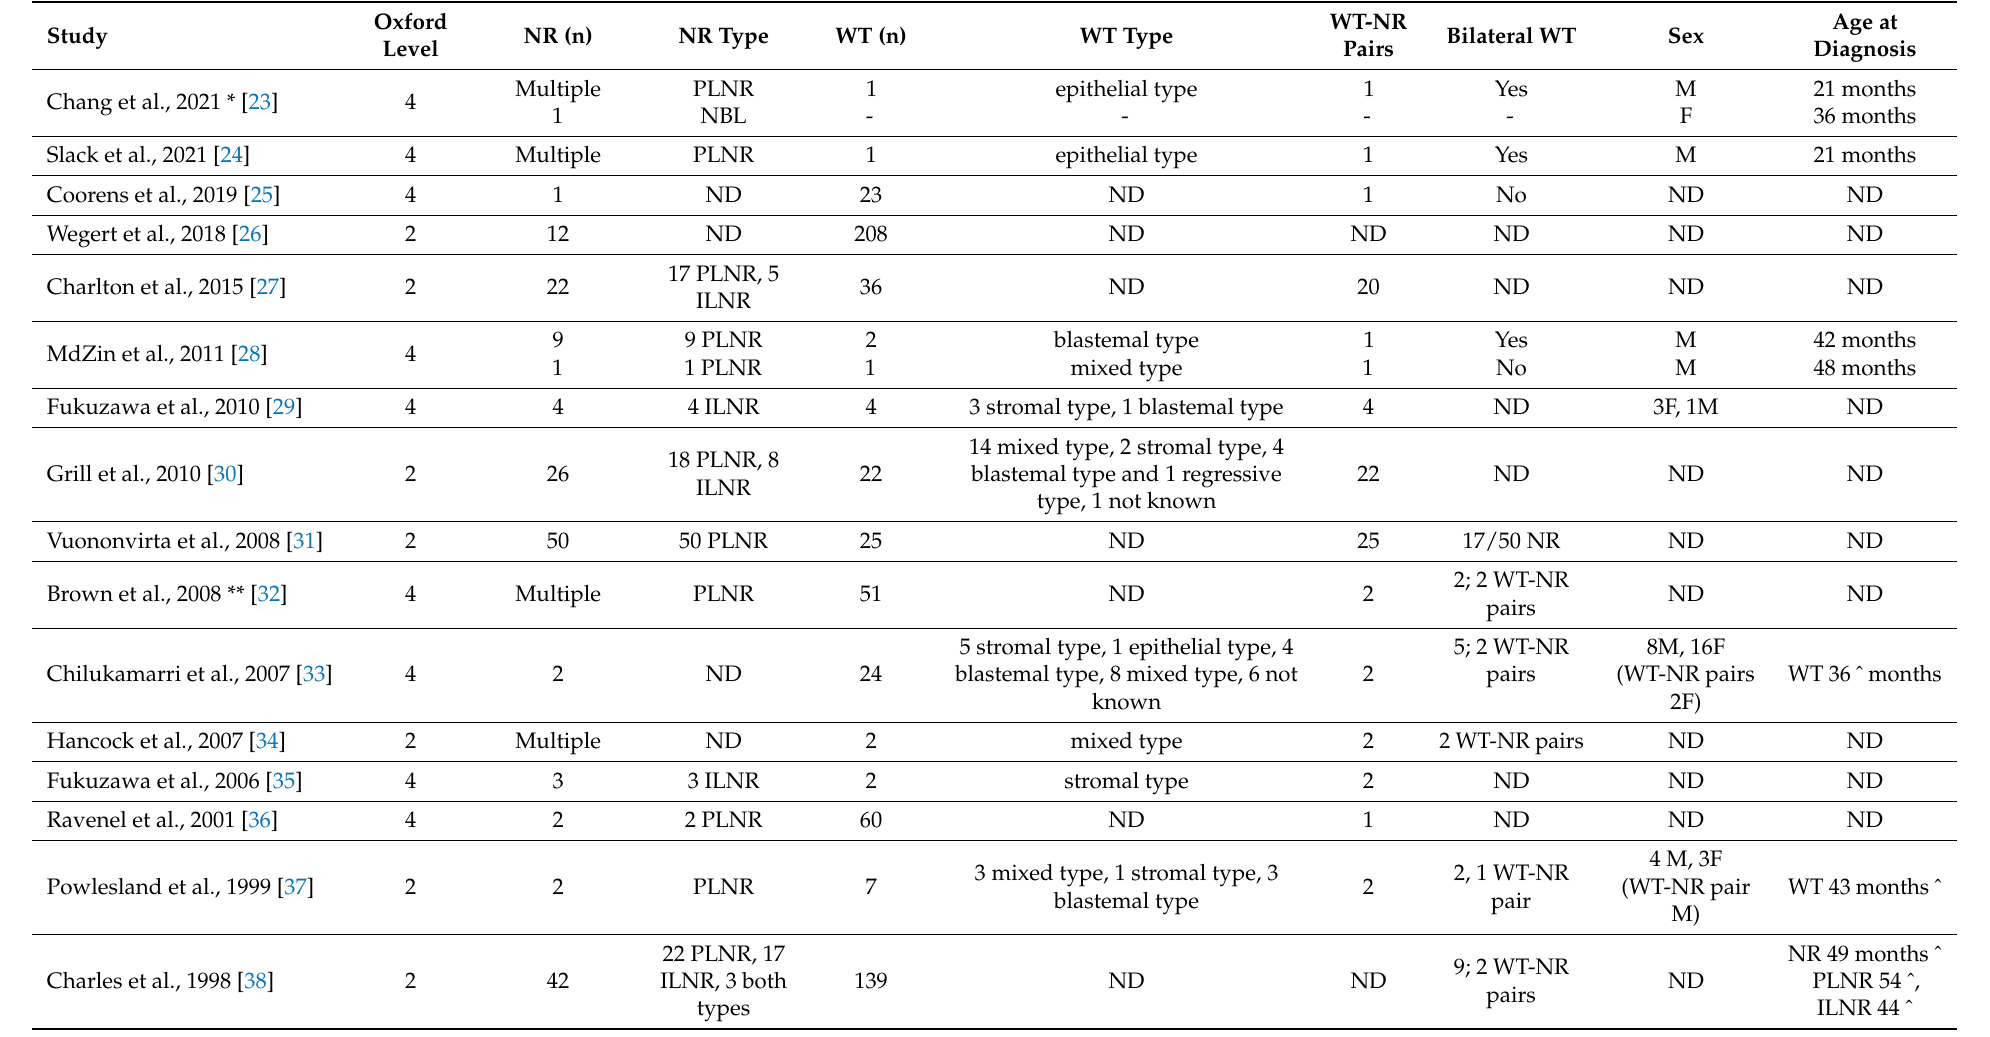
Table 1. Characteristics of reviewed NR